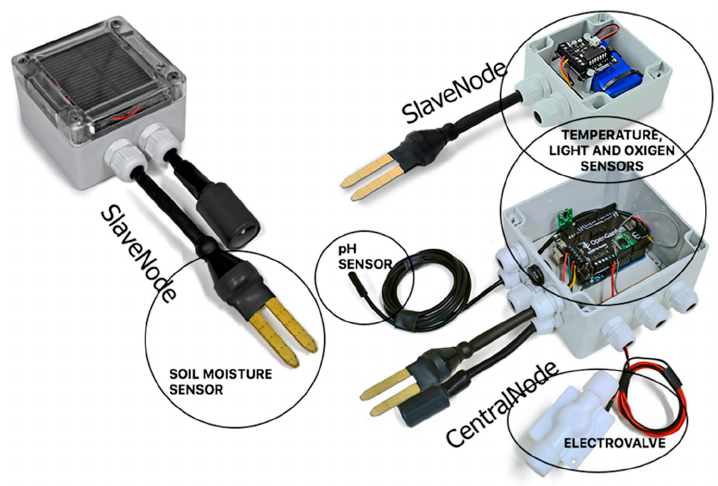
Figure 5. Look and feel of the devices.